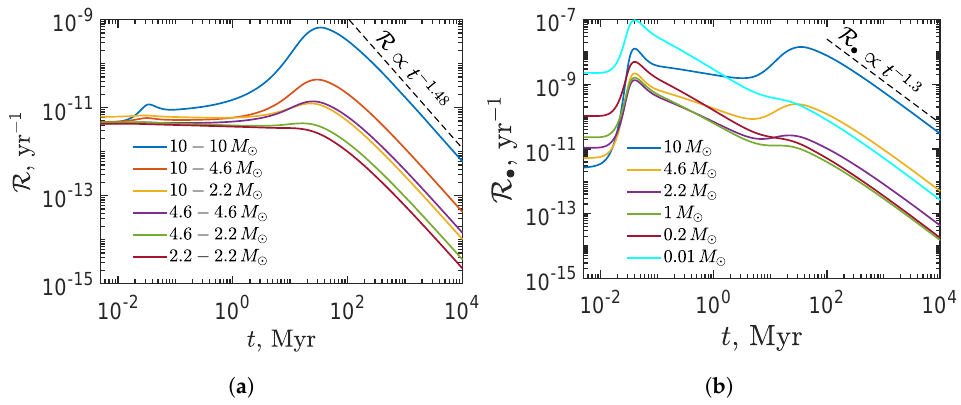
Figure 6. The merger rate time evolution for different type of PBHs mass. ( a ): The PBHs merger rate with each other. ( b ): The PBHs merger rate with the central massive